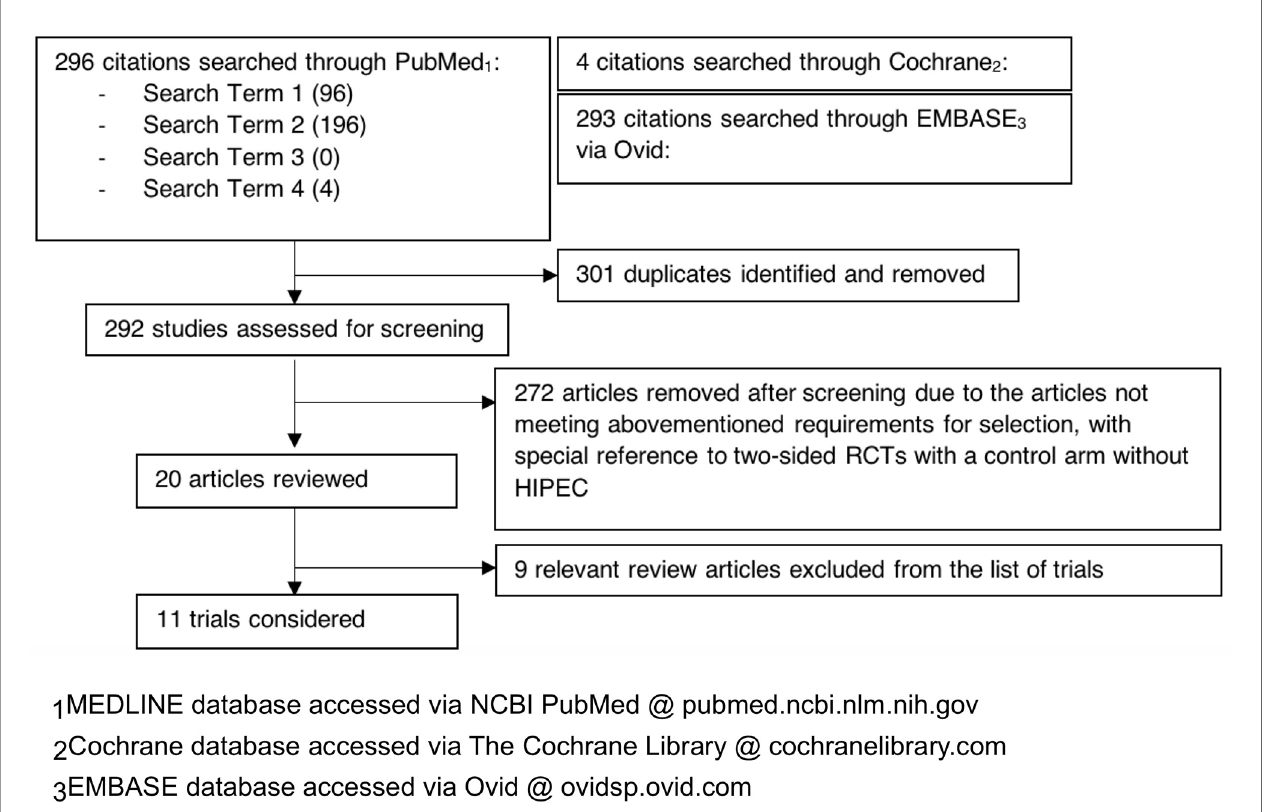
FIGURE 1 | PRISMA fl owchart denoting our literature search